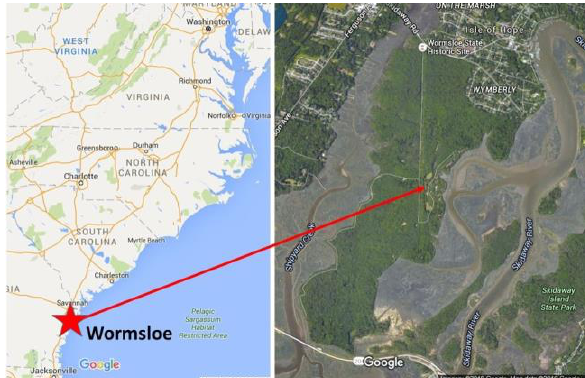
Figure 1. The Wormsloe State Historic Site is located on an interior barrier island just south of Savannah, Georgia,